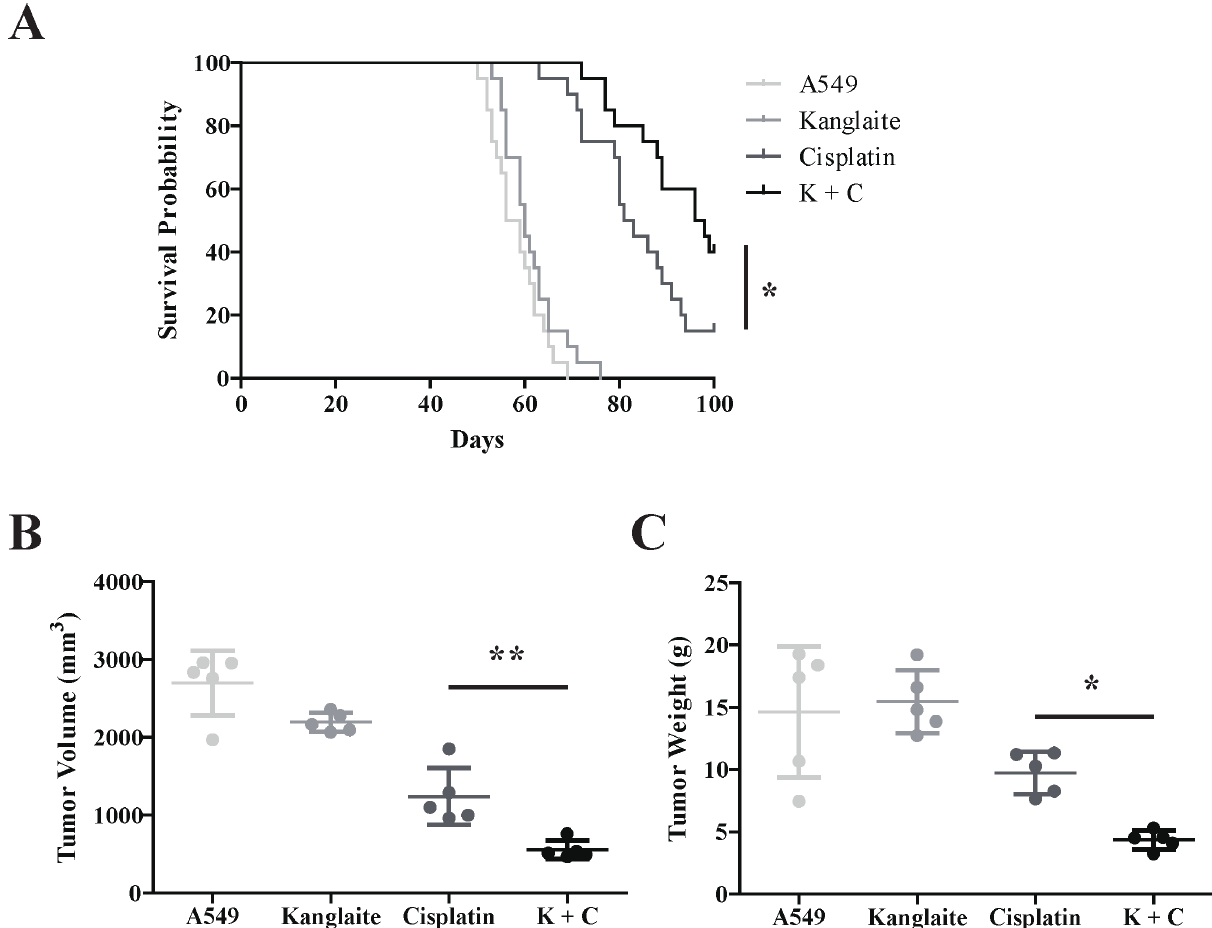
Fig. 1. Effects of Kanglaite on the growth of A549 cell-transplanted tumor in nude mice. Mice were subcutaneously injected with 5 × 10 6 A549 cells. (A) Survival probability was shown in the indicated group ( n = 20 for each group). (B) Tumor size was measured every 5 days and the vol- ume at day 50 was shown in the indicated group. (C) Tumor weight at day 50 was shown in the indicated group. Data shown as mean with SEM ( n = 5) and * P < 0.05 and ** P <